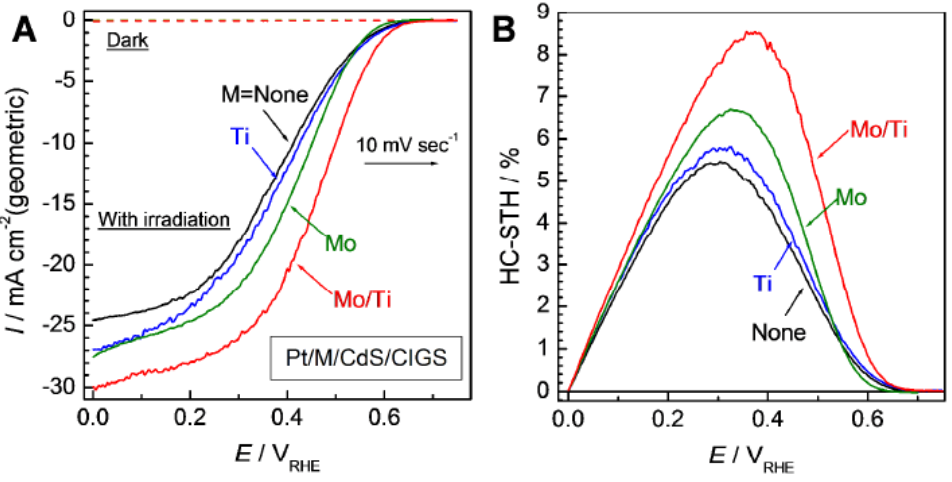
Figure 5. ( A ) Current-potential curves and ( B ) corresponding HC-STH values for Pt/M/Cu(In,Ga)Se 2 electrodes (M = none, Ti, Mo, Mo/Ti) [0.5 M Na 2 SO 4 (aq) + 0.25 M Na 2 HPO 4 (aq) + 0.05 M NaH 2 PO 4 (aq), pH 6.8, AM1.5G]. Reproduced from Reference [47] with permission (Copyright The Royal Society of Chemistry